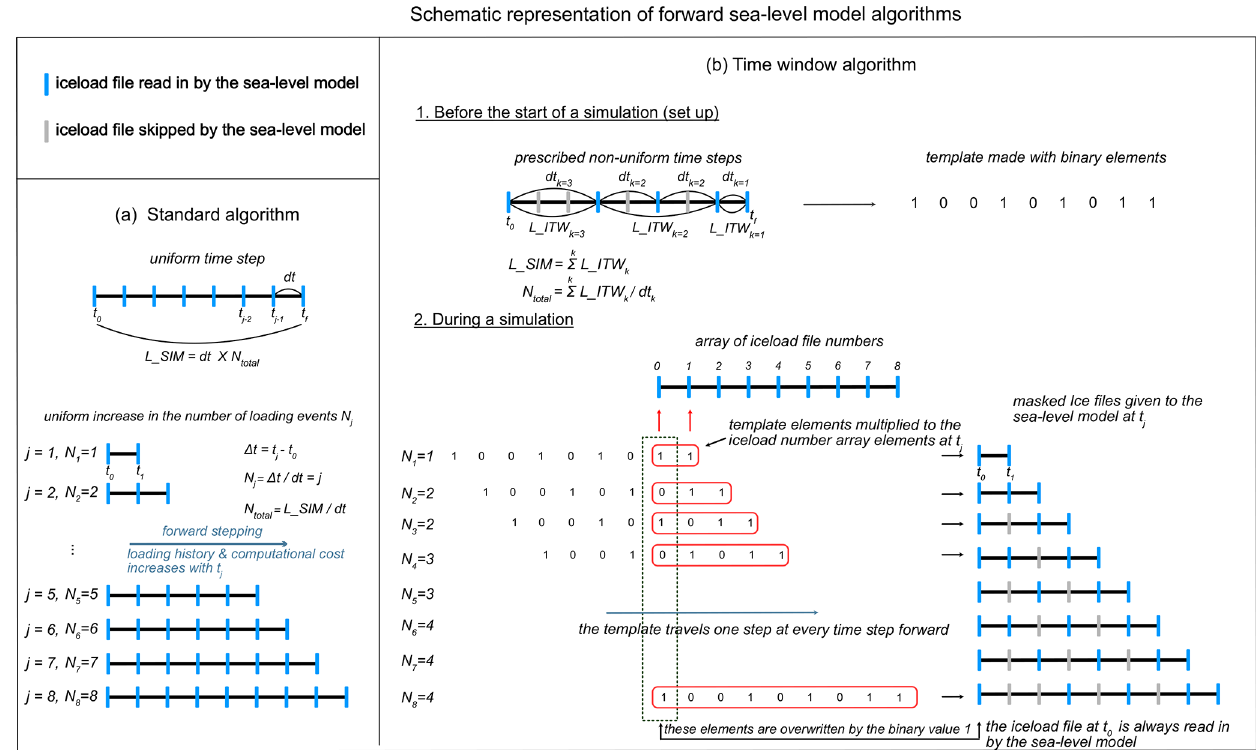
Figure 1. Schematic diagram of standard and time window algorithm in forward sea-level modelling. (a) The standard forward model algorithm in which the surface (ice sheet and ocean) loading history is captured in uniformly discretized temporal resolution. (b) The time window algorithm that captures the details of the loading history in non-uniformly discretized temporal resolution. The user assigns k number of internal time windows, each of which has a total length of L _ITW k and internal time steps of size dt k . The ice load files shown as blue vertical bars are multiplied by a template element with a value “1” (considered by the sea-level model), and grey bars are multiplied by “0” (ignored by the sea-level